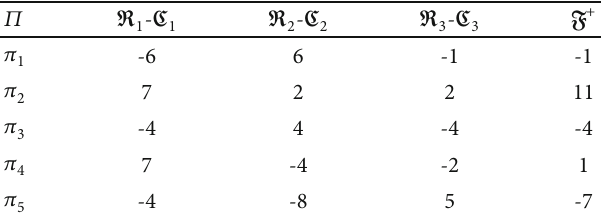
Table 10: The fi nal positive score table.